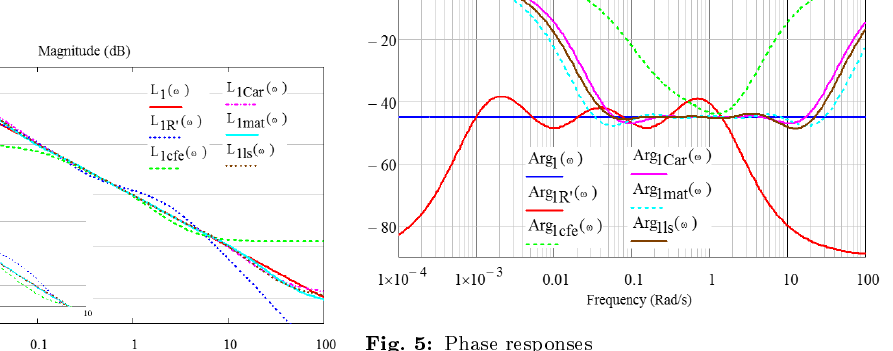
Fig. 5: Phase responses